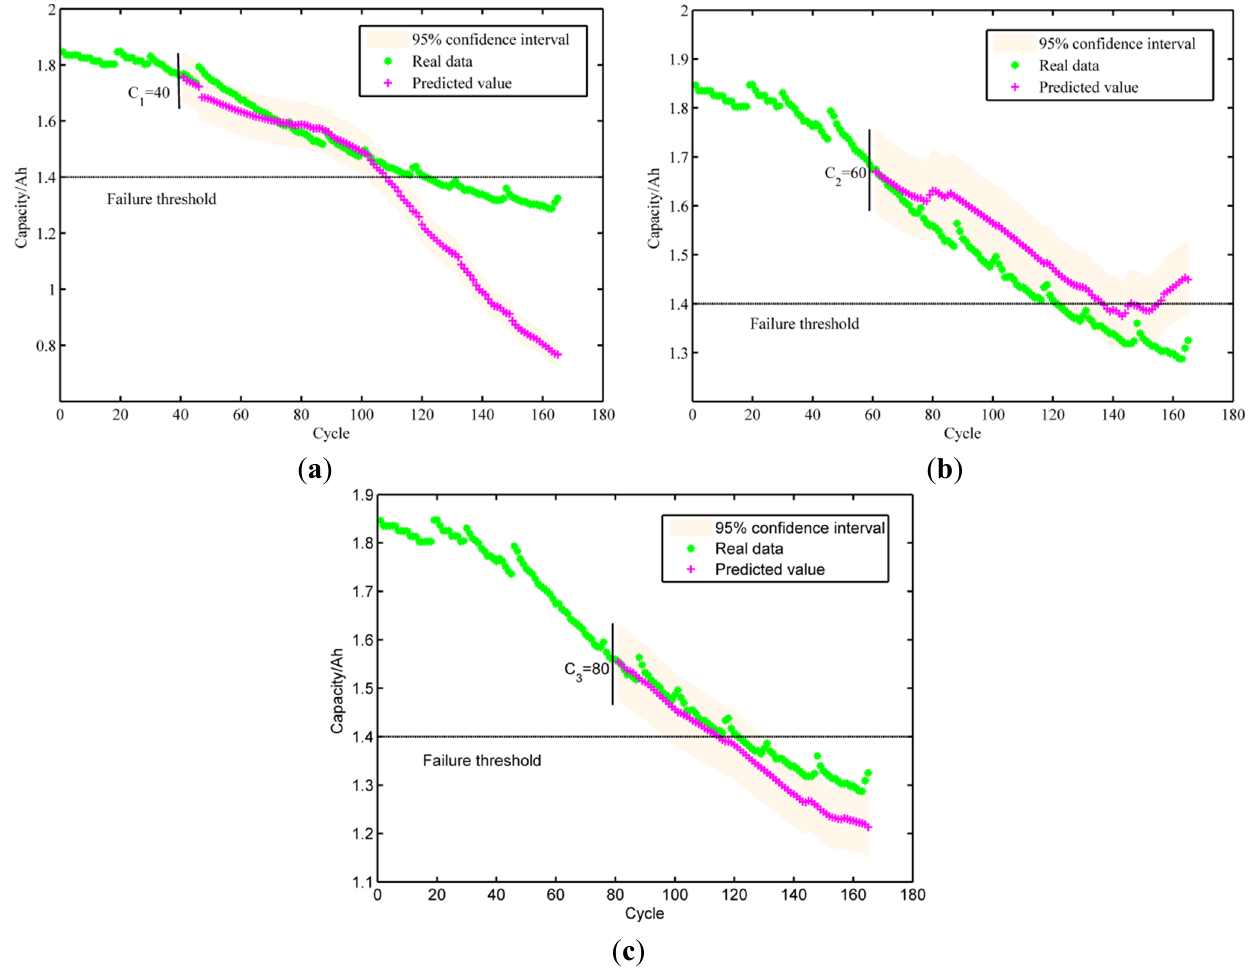
Table 3. Comparisons at different starting points for predicting the RUL of Battery No. 5. i th cycle SSE RMSE Real Cycle Predictive Cycle E 40th cycle 6.7649 0.1150 124 112 12 60th cycle 0.6719 0.0210 124 140 16 80th cycle 0.2807 0.0300 124 118